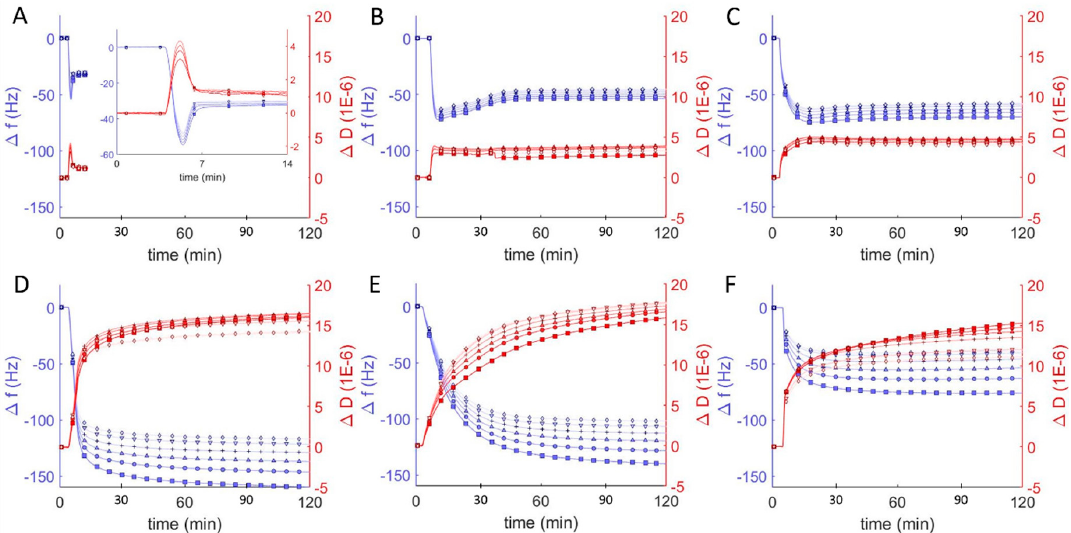
Figure 3. Frequency change ( ∆ f / n , blue) and dissipation ( ∆ D , red) measurements from QCM-D monitoring of hybrid polymer / lipid vesicles in Tris bu ff er (pH = 7) interacting with plasma cleaned borosilicate glass, showing data from the 3rd through 13th harmonics, 3rd ( □ ), 5th ( ○ ), 7th ( ∆ ), 9th (+), 11th (inverted triangles), 13th ( ♦ ). After establishing a baseline bu ff er solution measurement, vesicles composed of 100 mol % DOPC ( A ) and EO 22 Bd 33 in varying amounts: 10 ( B ), 25 ( C ), 50 ( D ), 75 ( E ), 100 ( F ) mol % were introduced into the sample QCM-D sample chamber.